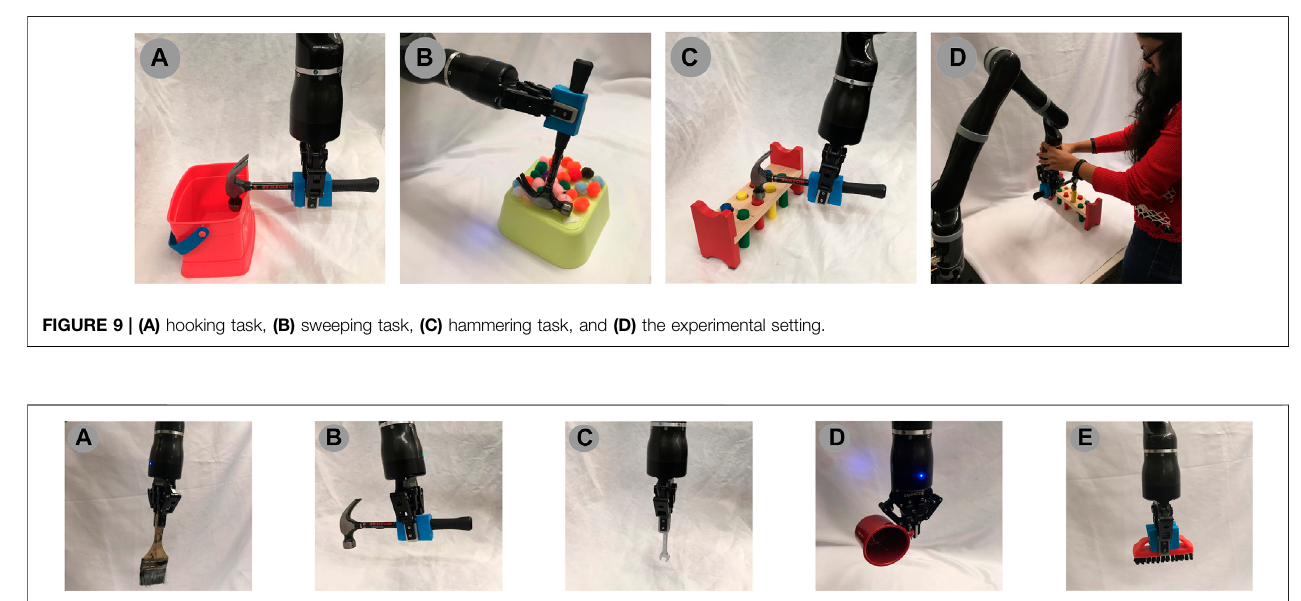
FIGURE 10 | Tools (A – C) were used to demonstrate the three tasks shown in Figure 9 , later transferred to use tools (D,E) . These tools exhibit a wide range of grasps, orientations, dimensions, and tooltip surfaces.